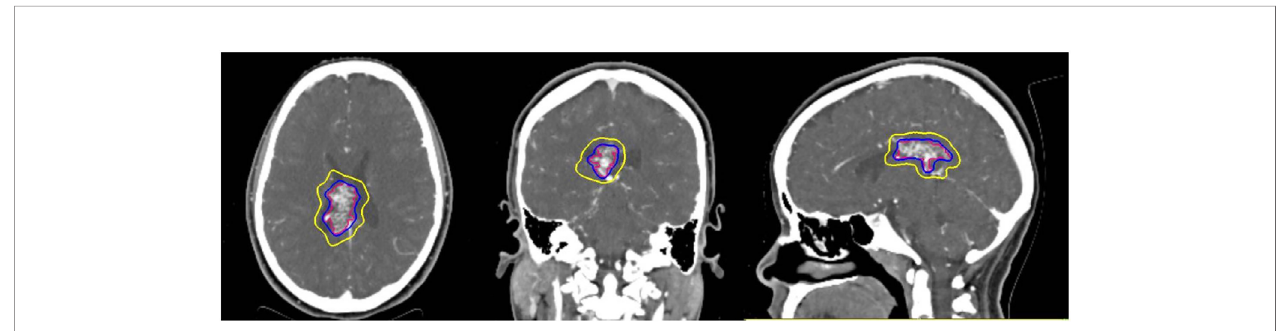
FIGURE 1 | Representative stereotactic radiosurgery case with planned treatment volume (red) isodose (blue) and 50% isodose (yellow) can be seen in three planes on pretreatment planning